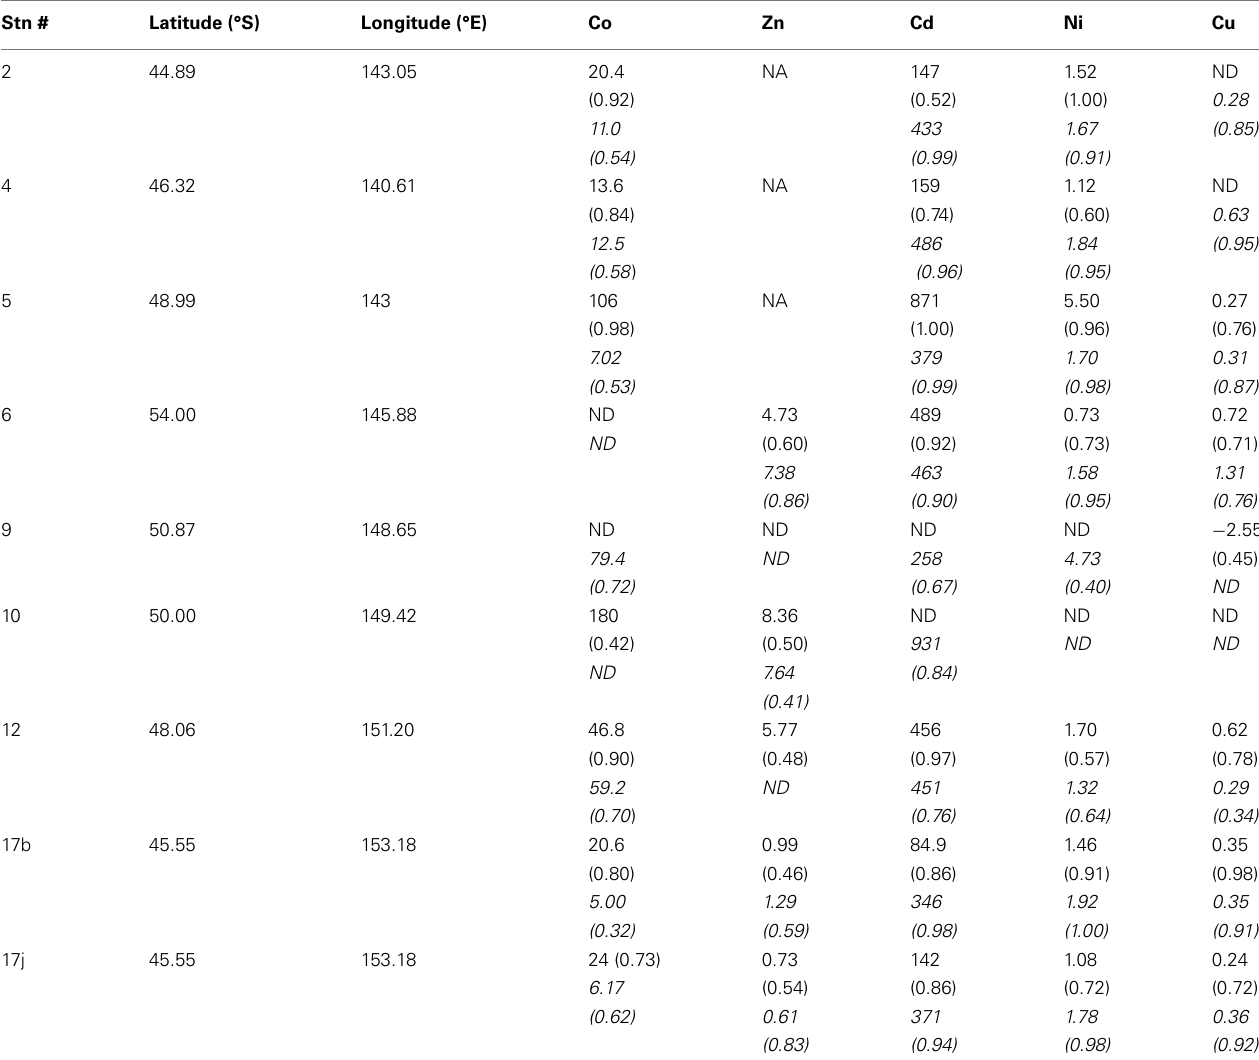
TableA2 | Metal disappearance ratio relative to dissolved phosphate for each